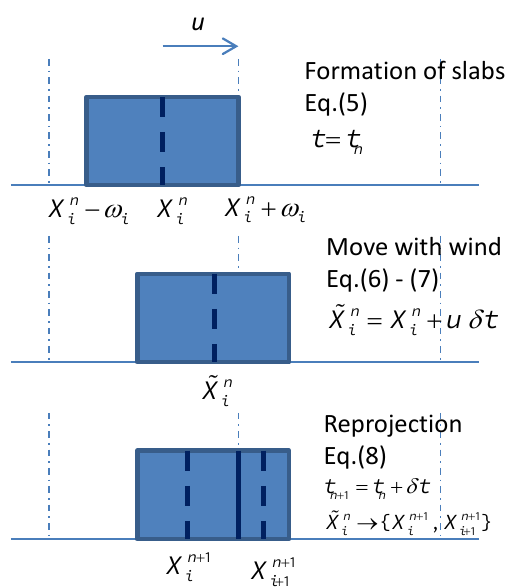
Figure 1. Advection step of the scheme of Michael Galperin.